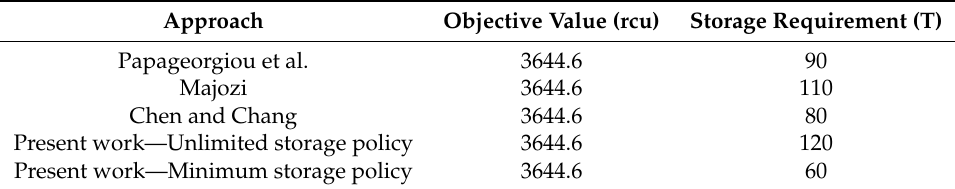
Table 6. Comparison of optimal solutions for 48 h scheduling horizon solution for BR-S